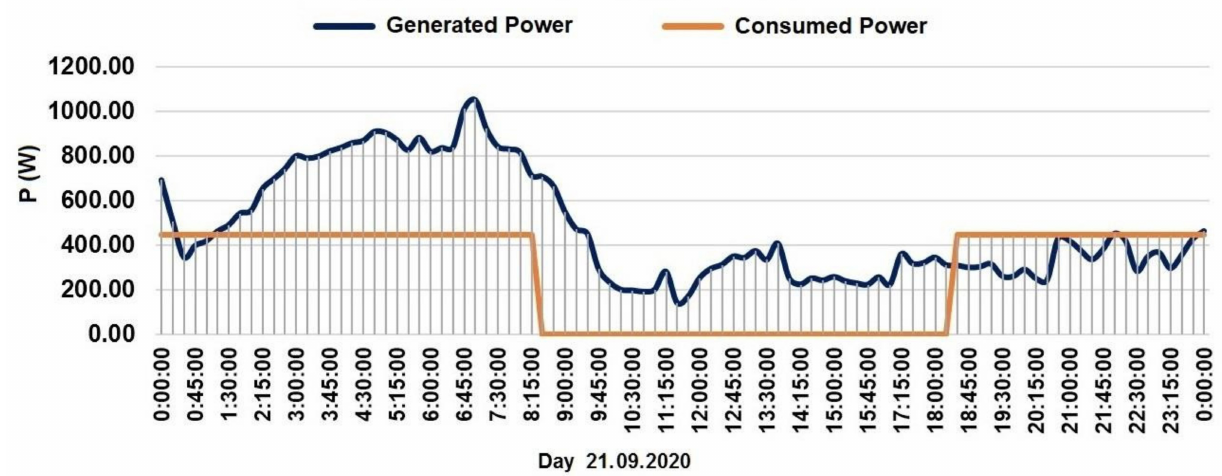
Figure 12. Energy produced and consumed (with a theoretical consumption of 14.5 h of lighting operation, with the longest night of the year as a worst-case scenario) on an average day of